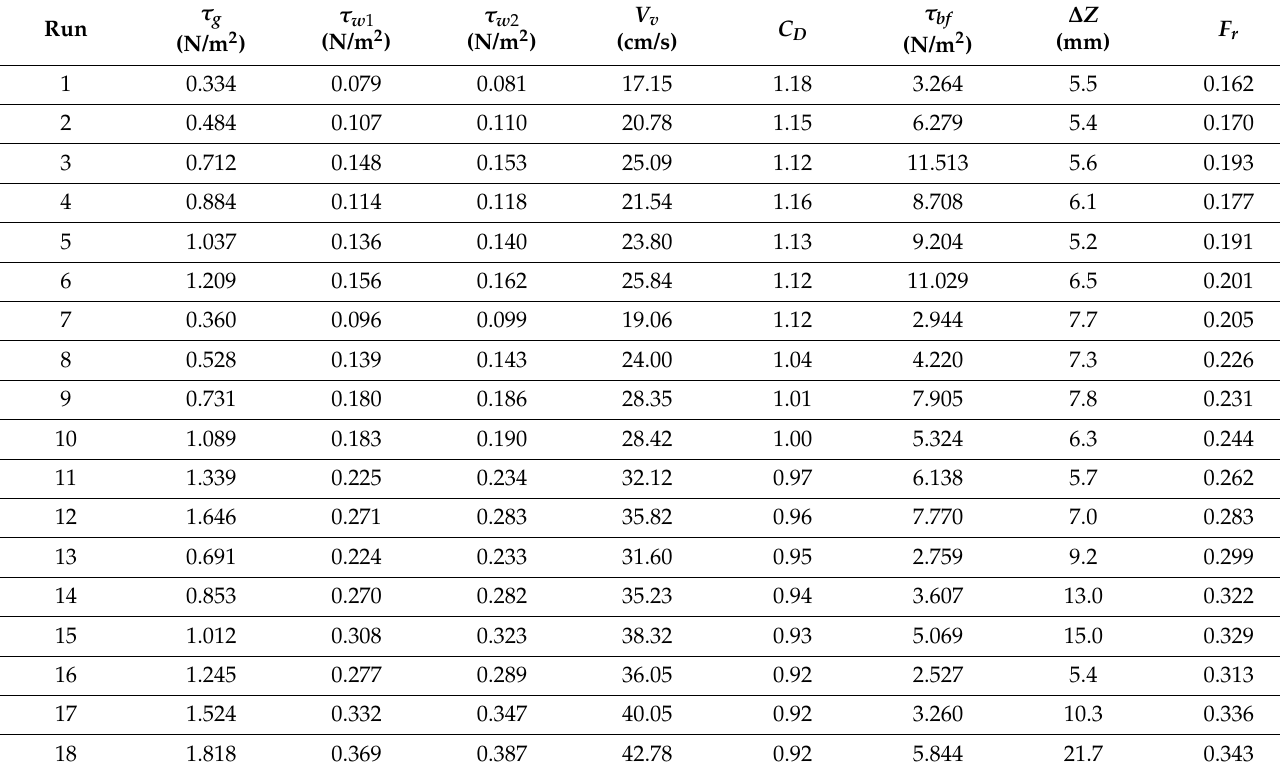
Table 2. Experimental runs processing